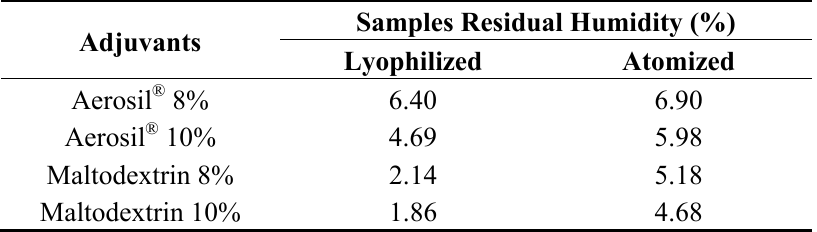
Table 1. Residual humidity (%) of the atomized and lyophilized samples using Aerosil ® or maltodextrin as adjuvant.